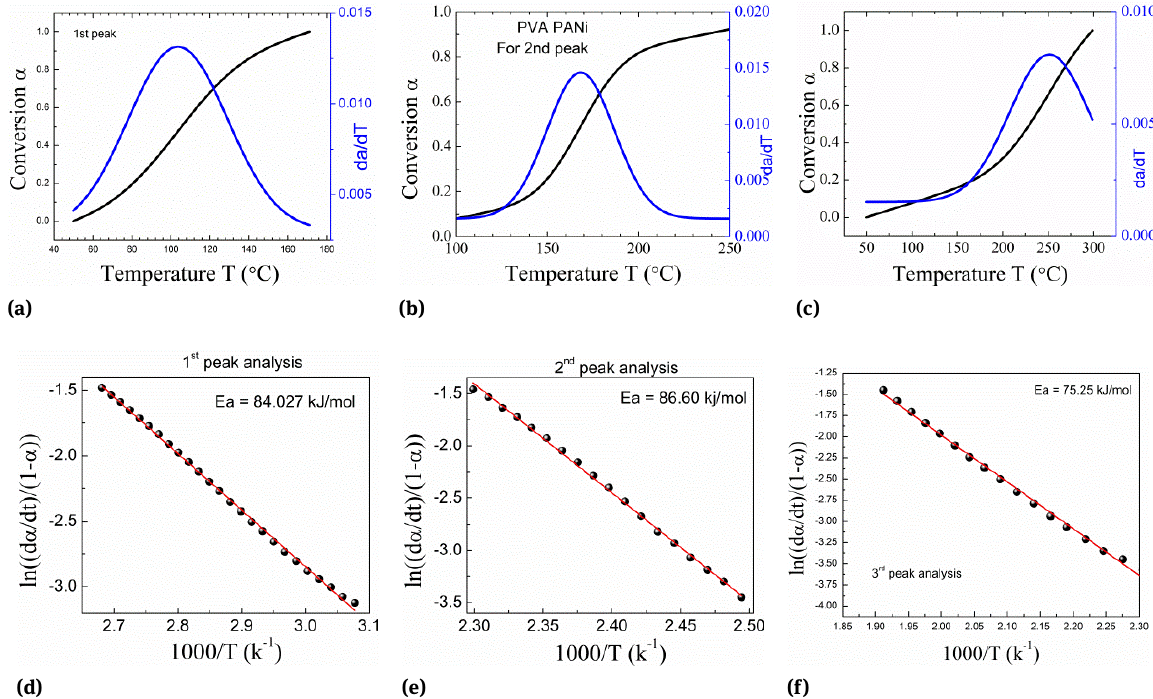
Figure 13: Conversion rate and its 1 st derivative for the a) first reaction, b) second reaction, and c) third reaction, and ln[(d α /dt)/(1 - α )] vs. 1/T relation for the d) first reaction, e) second, reaction and f) third reaction of the PVA/PANi blended sample.